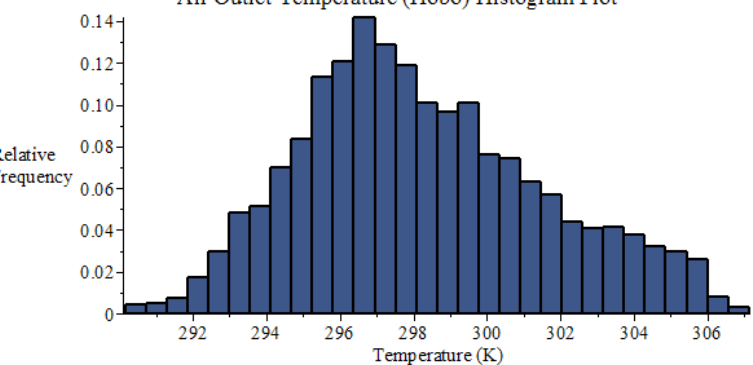
Table A2. Statistics of the air outlet temperature distribution [K], measured using “Tidbit” sensors.